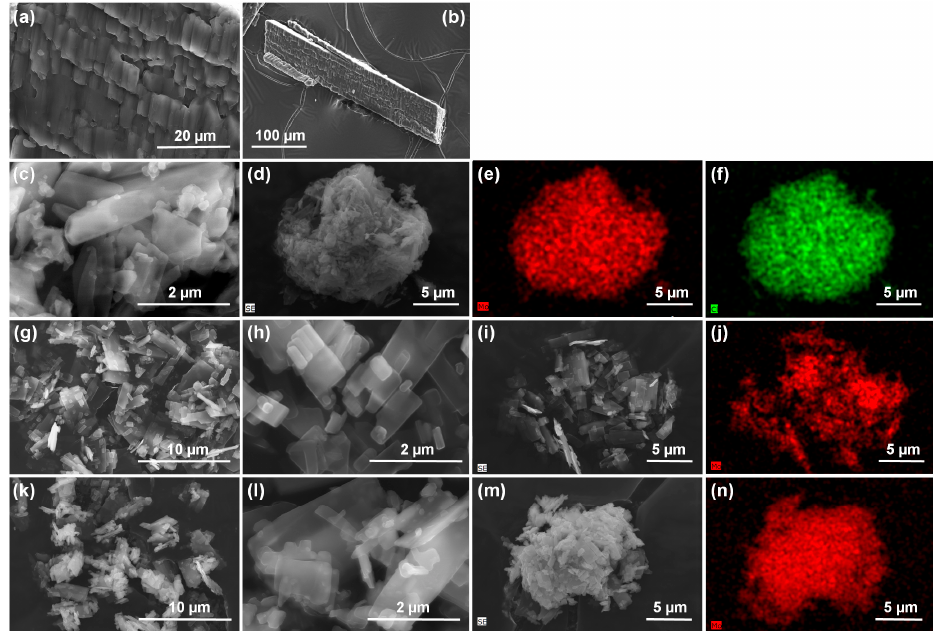
Figure 11. SEM images and respective element distribution mappings (in selected cases; Mo (red), Cl (green)) of ligand Hpytz ( a , b ), 1 ( c – f ), 2 ( g – j ), and 2 ‐ TFT ‐ run1 ( k – n ).